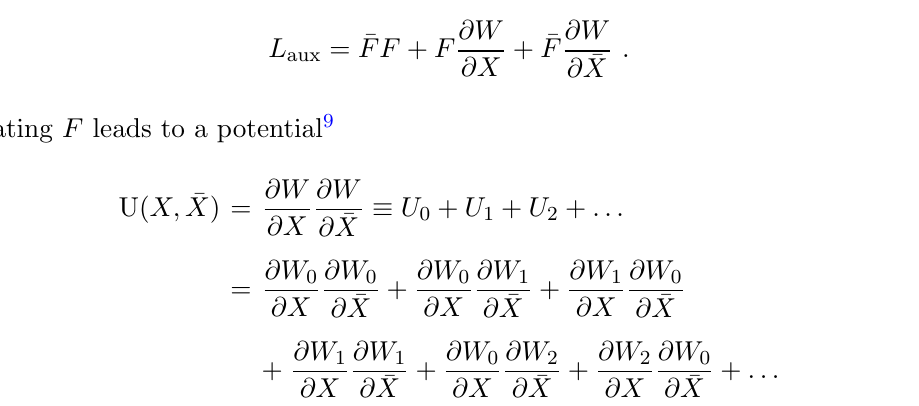
Figure 2 . Phase diagram for an N = 1 U( N ) mental matter